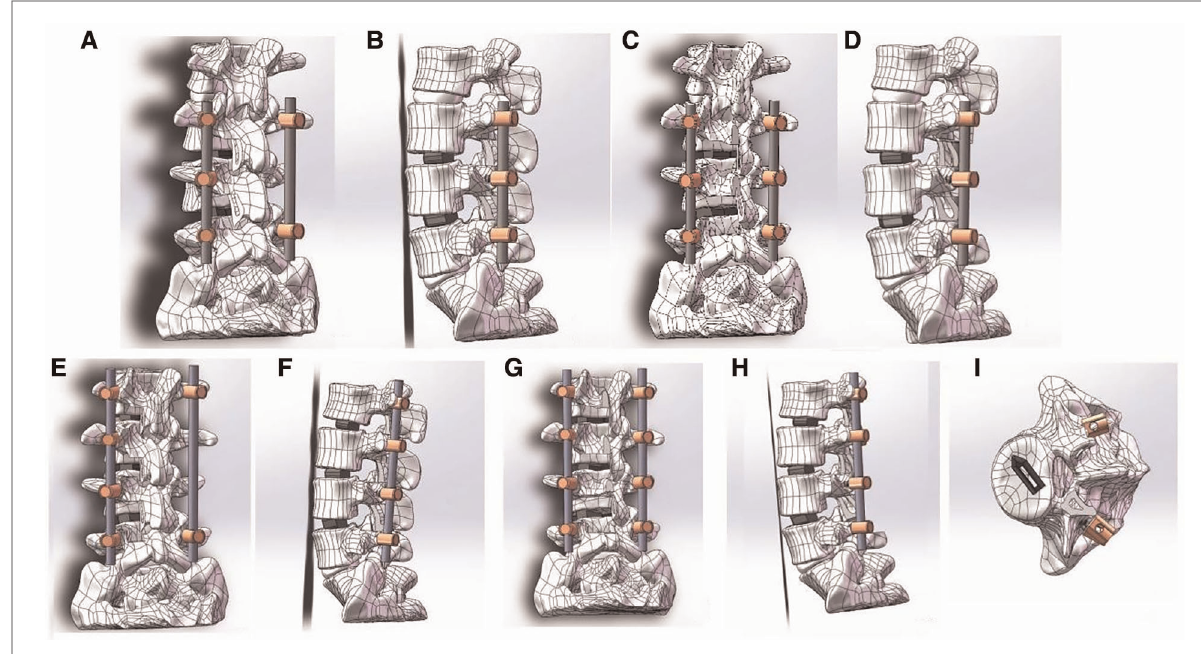
FIGURE 5 The procedure of two kinds of TLIF simulation and establishment of postoperative FE model. ( A ) Schematic diagram of 2-level smile-face surgery: positive view; ( B ) Schematic diagram of 2-level smile-face surgery: lateral view; ( C ) Schematic diagram of 2-level open TLIF surgery: positive view; ( D ) Schematic diagram of 2-level open TLIF surgery: lateral view; ( E ) Schematic diagram of 3-level smile-face surgery: positive view; ( F ) Schematic diagram of 3-level smile-face surgery: lateral view; ( G ) Schematic diagram of 3-level open TLIF surgery: positive view; ( H ) Schematic diagram of 3-level open TLIF surgery: lateral view; ( I ) vertical view of bullet cage.